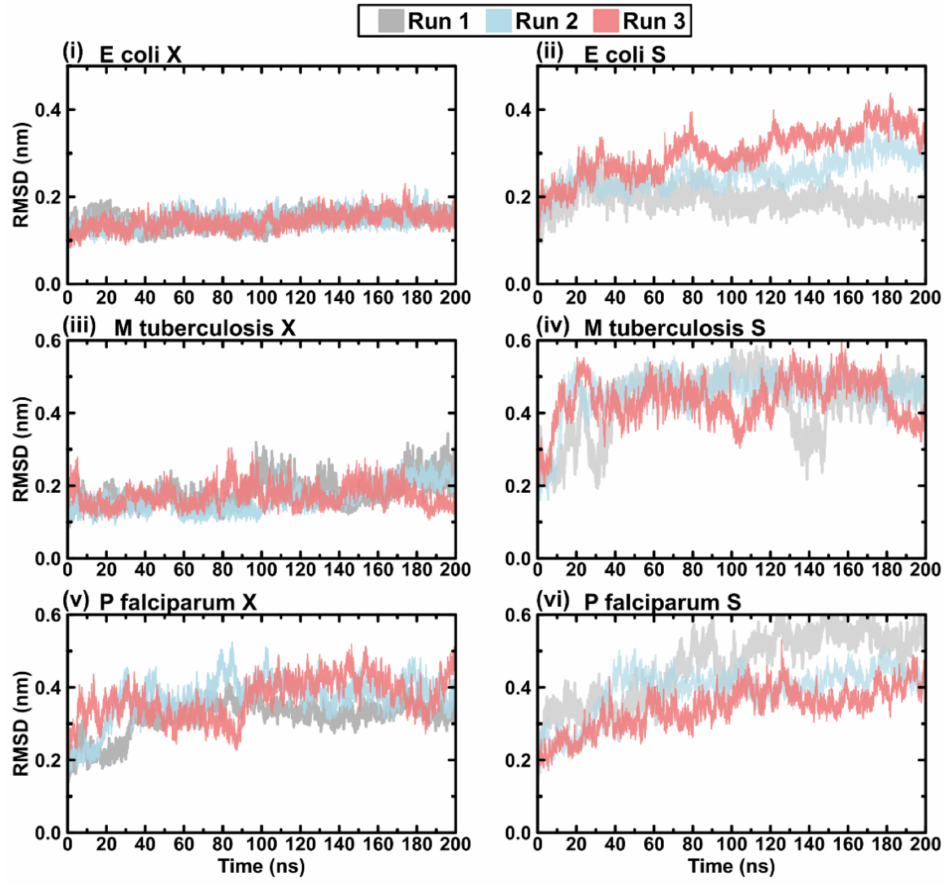
Figure 7. Plots of protein RMSD for the triplicate MD runs: ( i ) the crystal structure models of E. coli , ( ii ) the separated loop models of E. coli , ( iii ) the crystal structure models of M. tuberculosis , ( iv ) the separated loop models of M. tuberculosis , ( v ) the crystal structure models of P. falciparum , and ( vi ) the separated loop models of P. falciparum . Colour key: run 1 (grey), run 2 (blue), and run 3